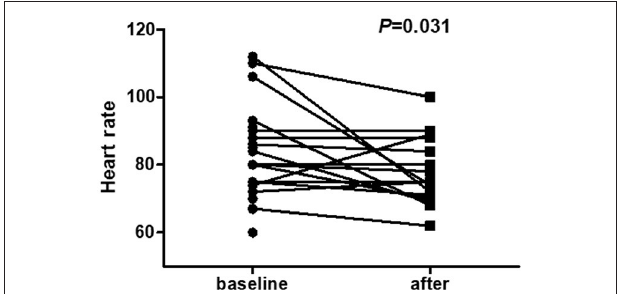
FIGURE 1 | Heart rate of PD patients before and after initiating sacubitril-valsartan with an observation period of 3–12 months. Paired samples t -test was employed to compare self-matching data on heart rate levels. Results show that compared with baseline levels, heart rate is